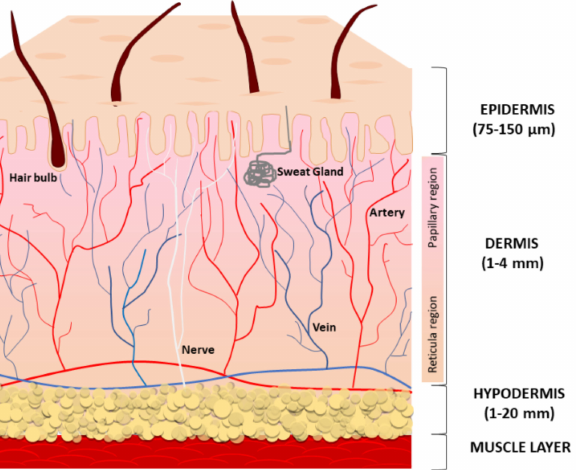
Figure 1. A schematic representation of the structure and functions of the skin. Human skin is composed of three layers: the epidermis (the top layer), the dermis (the middle layer), and the hypodermis (the bottom fatty